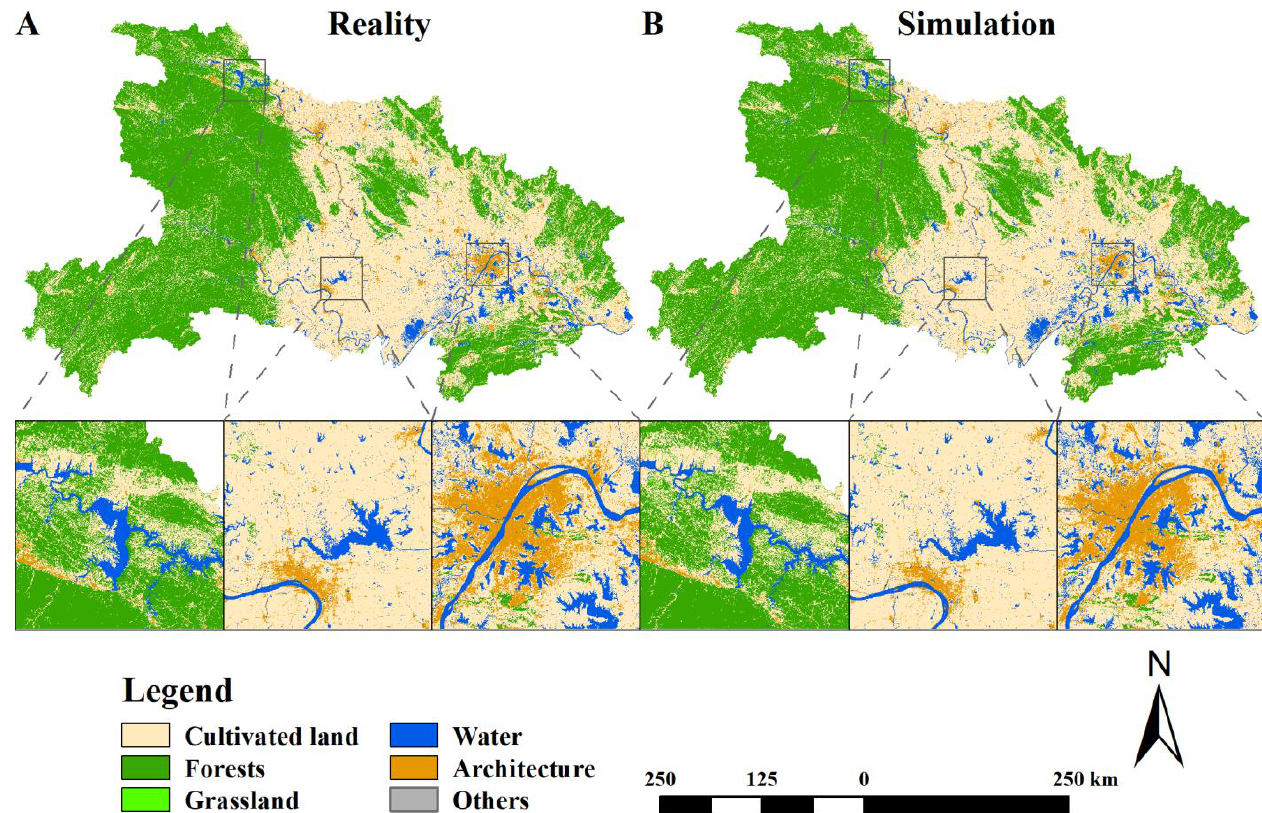
Figure 4. Comparison of reality and simulation details of land use in 2020. ( A ) Reality; ( B ) simulation.